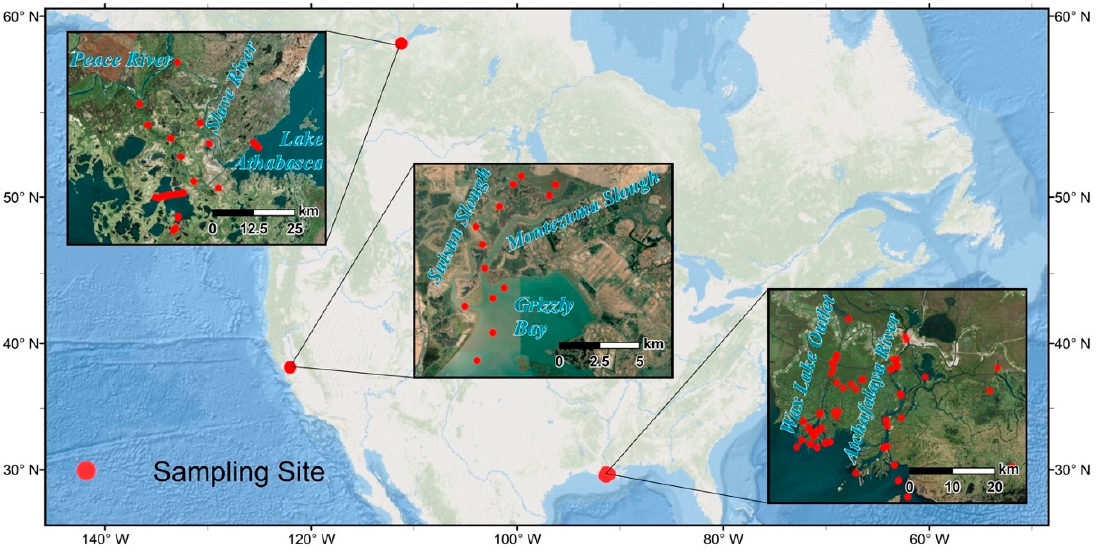
Figure 1. The study areas corresponding to water sample and spectroscopic measurement locations: Canada’s Peace–Athabasca Delta (top-left), Grizzly Bay in California’s San Francisco Bay–Delta Estuary (middle), and the Louisiana’s Wax Lake Delta and Atchafalaya River—this study’s primary study area (bottom ‐ right).